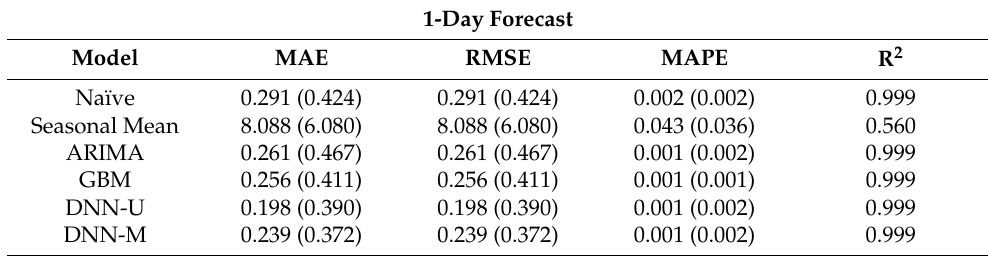
Table 5. Estimates for MAE, RMSE, MAPE, and R 2 calculated using TSCV for a 1-day forecast.